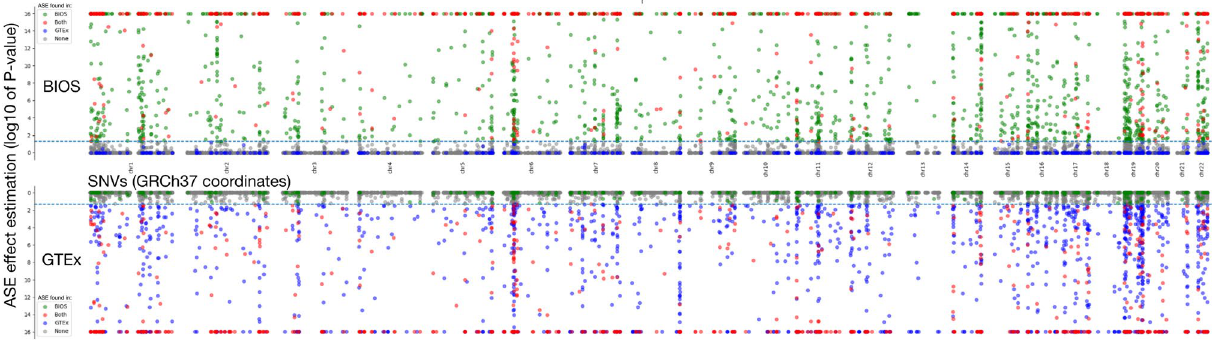
Figure 1. Genomic location of SNVs and their ASE effects. Each dot represents an SNV that is present in both BIOS and GTEx. The genomic location (GRCh37) of each SNV is plotted along the X-axis. The ASE effect, estimated as the log10 P -value, is plotted along the Y-axis. The color of each dot indicates the cohort in which a significant ASE effect was detected. The dotted line indicates the FDR 0.05 threshold. Plot was produced by Matplotlib 68 version 3.0.0 under Python 69 version